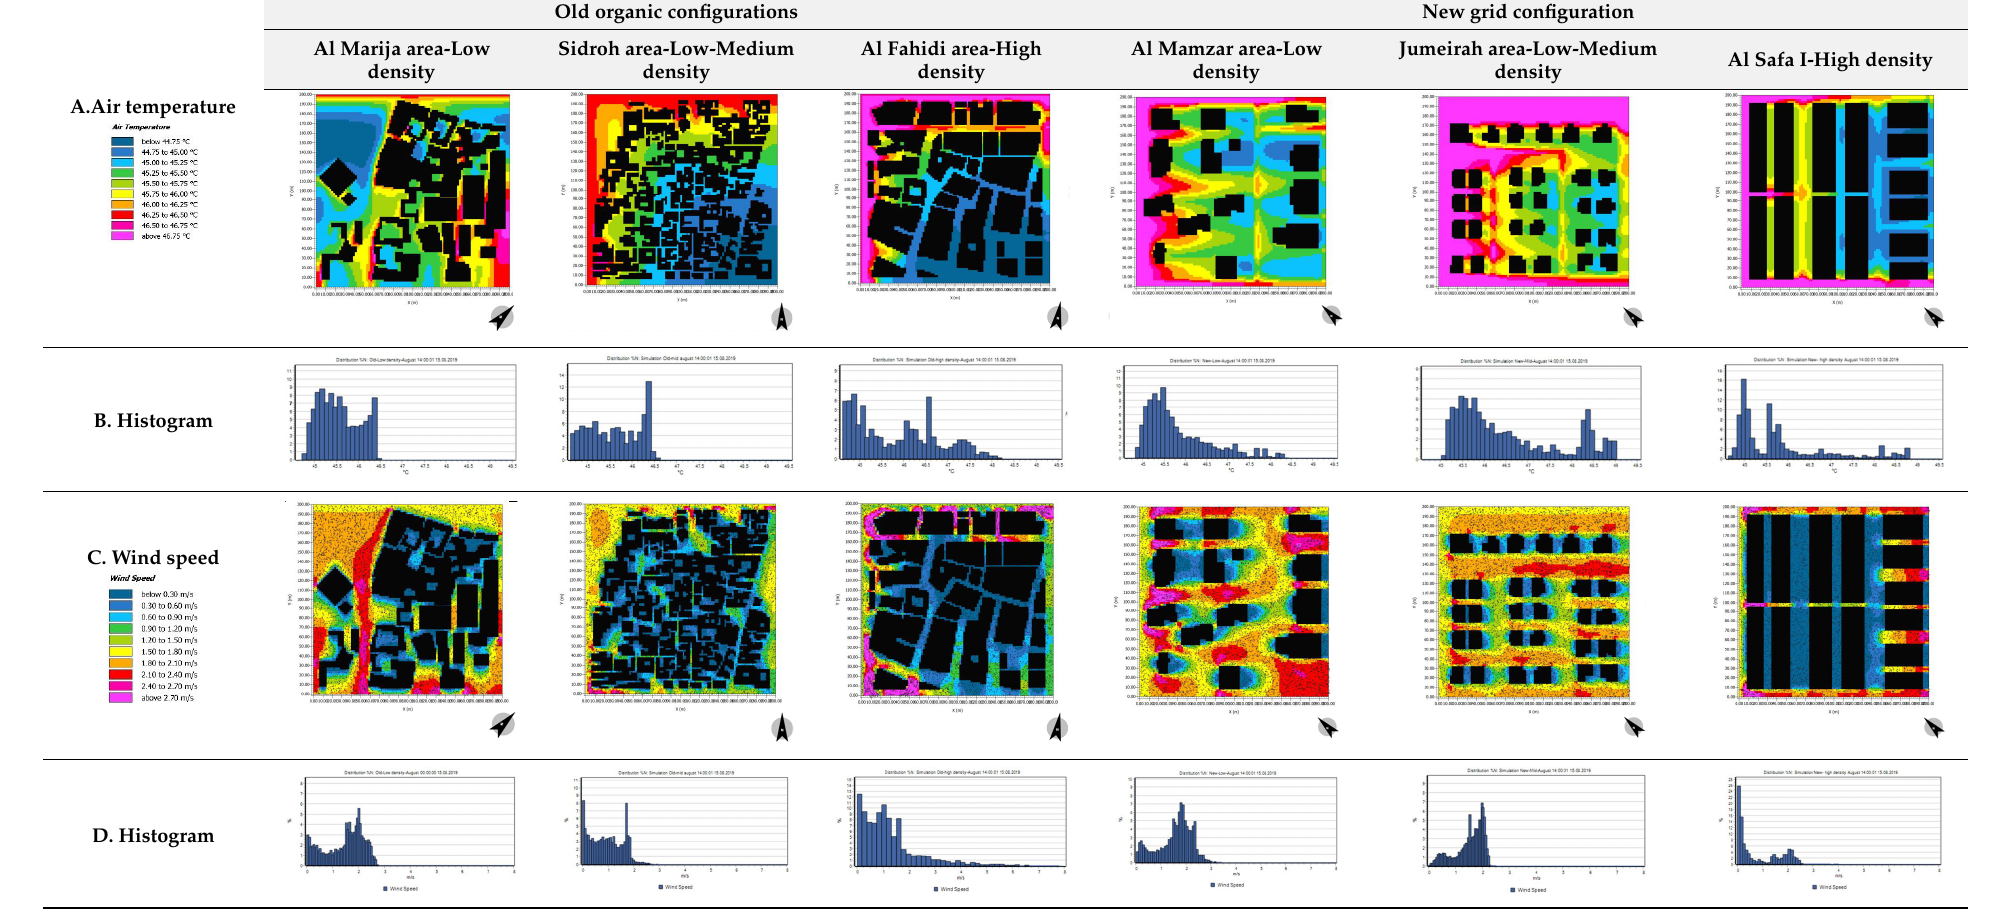
Table 7. Air temperature and wind distribution for the six sites on the 15 August. (Images generated by ENVI-met).